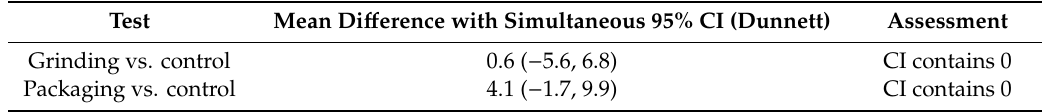
Table 6. Results of Dunnett’s test.